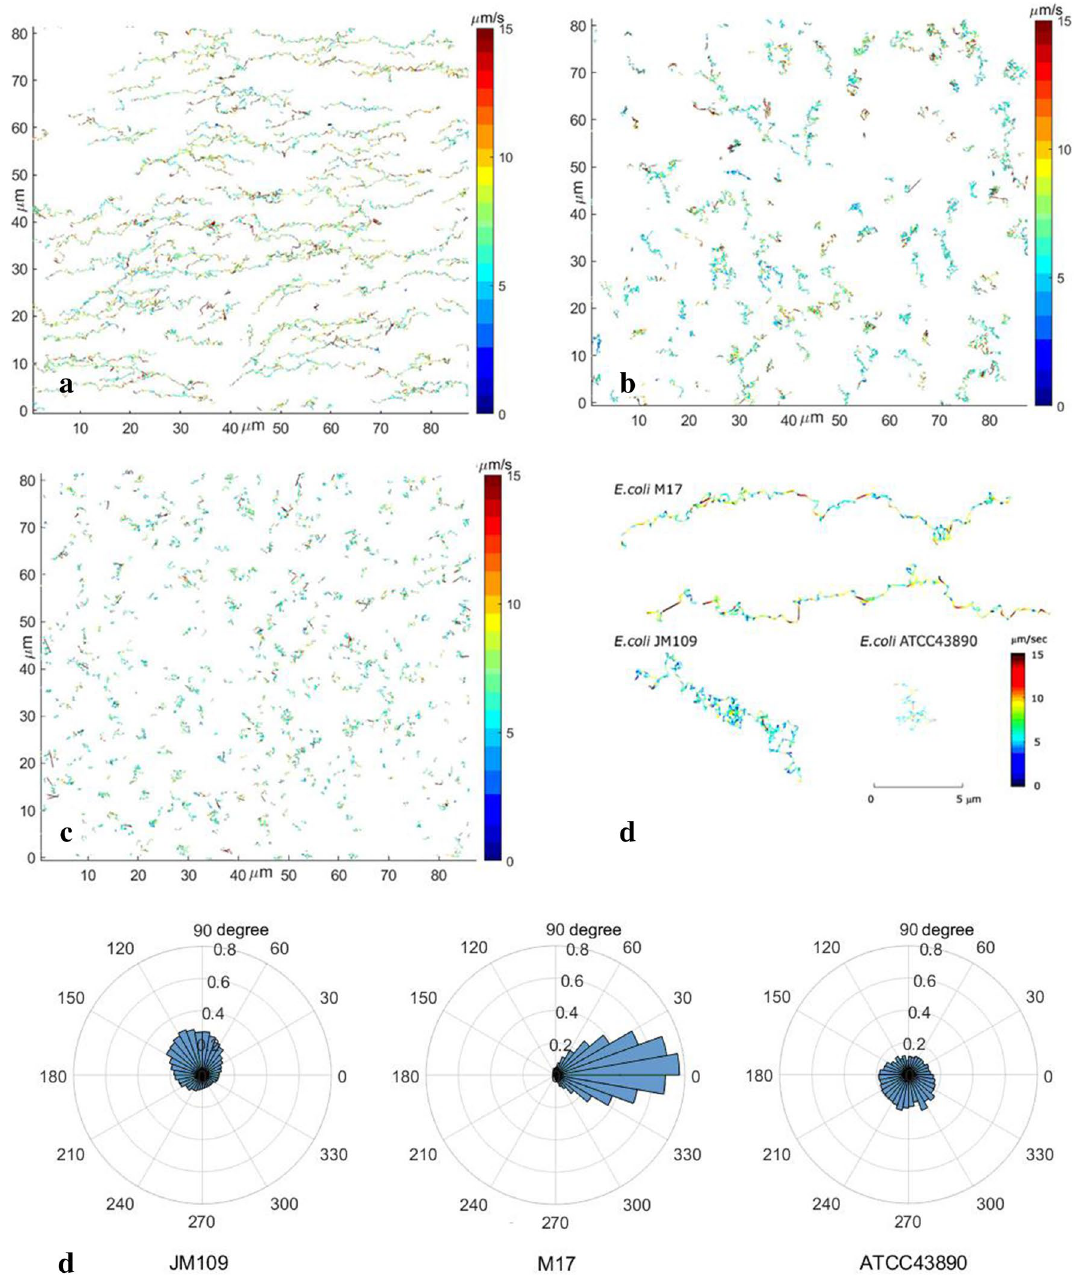
Figure 4. Reconstructed trajectories, color-coded according to the values of instantaneous velocities, for different strains of E. coli : ( a ) M17 ( b ) JM109 ( c ) ATCC43890. ( d ) Typical trajectory for each strain. ( e ) Angle distributions of instantaneous velocity vectors for each strain. M17 exhibits pronounced collective motion in one